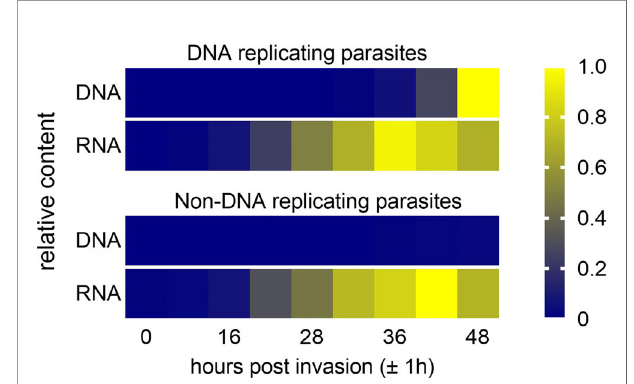
FIGURE 2 | Estimation of total DNA and total RNA content during a proliferative cycle of P. falciparum blood stages. Synchronized cultures of DNA replicating (PfCRK4-DD on Shield-1) and non-DNA replicating (PfCRK4- DD off Shield-1; Ganter et al., 2017) parasites were treated with or without RNase. Subsequently, parasites were stained with SYBR green I, which labels both DNA and RNA (Theron et al., 2010; Ganter et al., 2017) and analyzed by fl ow cytometry. Total DNA and total RNA contents were estimated by calculating the difference in signal intensity with and without RNase treatment. Total DNA and total RNA contents were normalized by Min-Max scaling using the minimum and maximum values for DNA and RNA regardless of whether parasites replicate DNA or